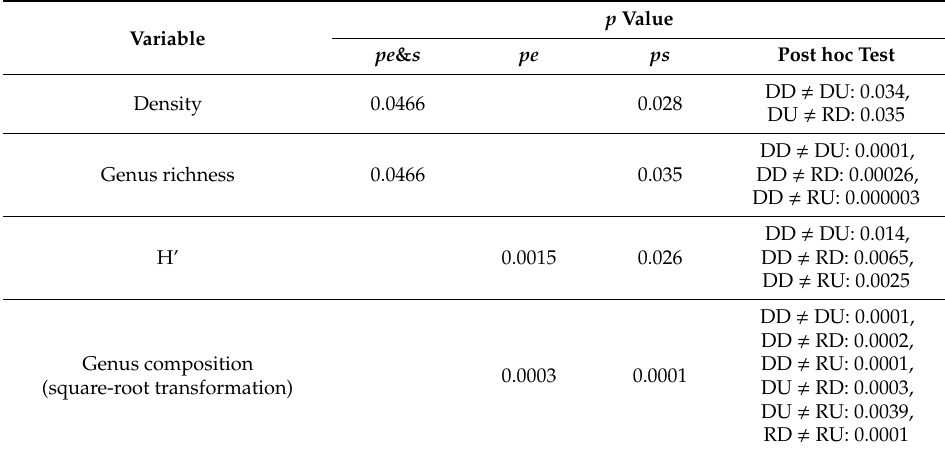
Table 2. The significant p values generated from ANVOVA / permutational PERMANOVA and pairwise comparison analyses for characteristics of nematode communities. ( pe&s: the significant interaction effect of both factors estuary and estuarine-section, pe: the significant estuary effects, ps: estuarine-section effect. “ ≠ ” sign indicated for the significant differences).